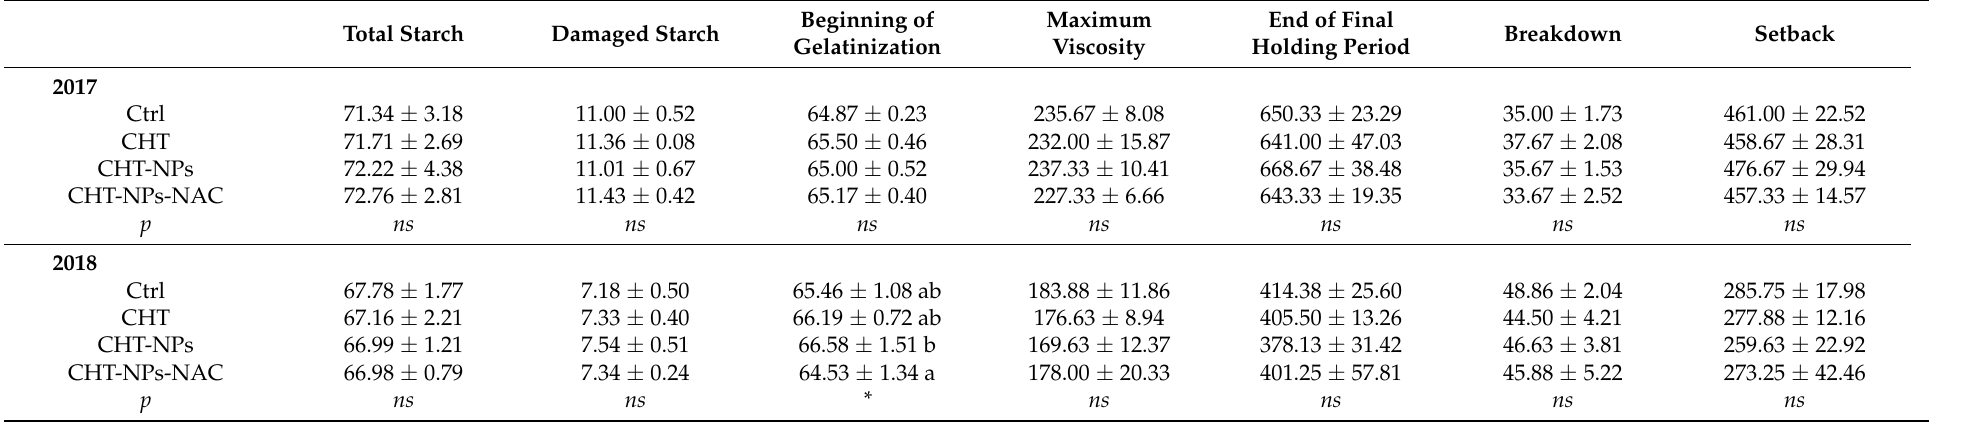
Table 3. Total and damaged starch (g/100 g db) and pasting properties of semolina obtained from Triticum durum (cv. Fabulis) in 2017 and 2018, untreated (Ctrl)